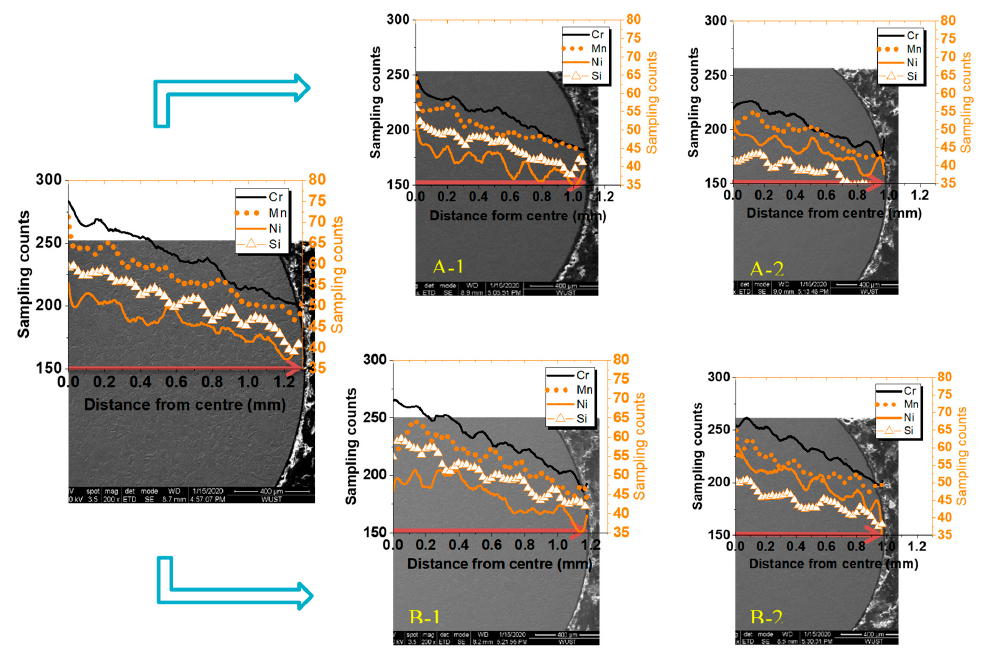
Figure 6. Liner scanning of the element distribution on cross section. (The red arrow line is the scanning routine). Table 3. The maximum and minimum values of the EDS results for the tested samples.